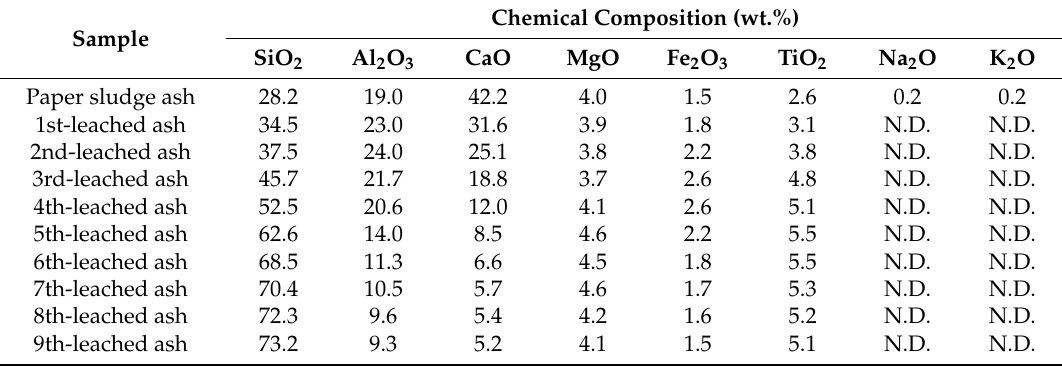
Table 1. Chemical composition of paper sludge ash and leached